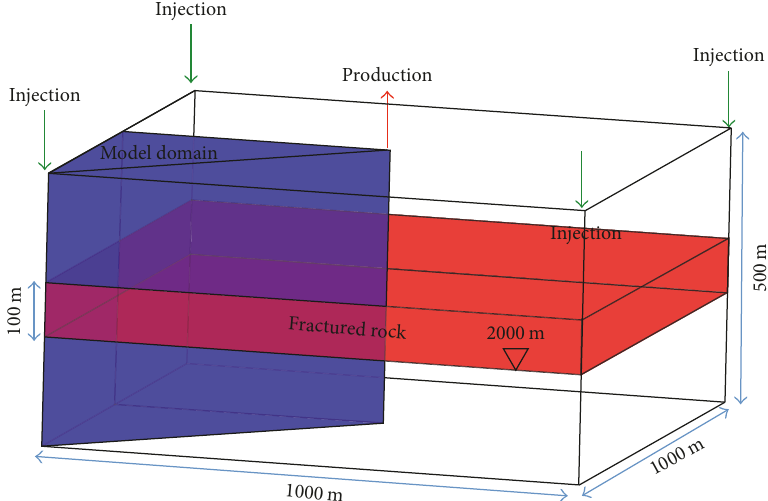
Figure 1: Schematic of the 3D numerical model domain with a 5-spot well pattern (1/8 system domain used for all simulations).